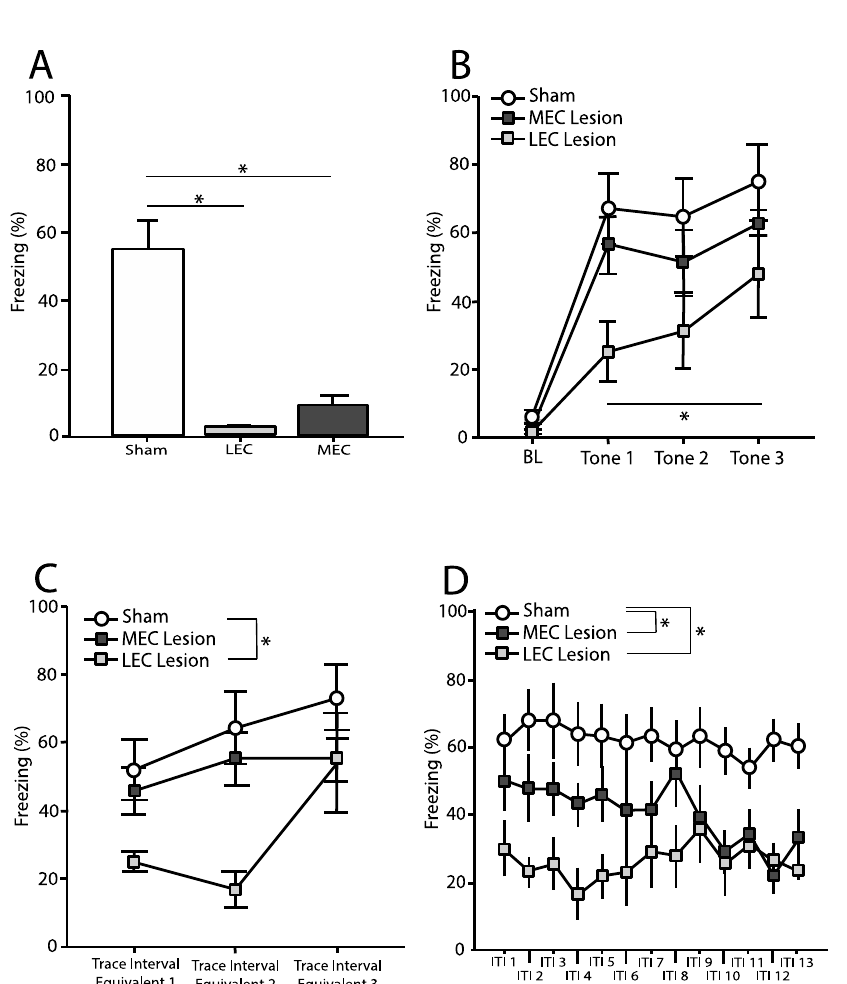
Figure 4. Mean (±SEM) percentage time spent freezing during the context test and tone test for rats trained using delay conditioning . ( A ) Freezing during the entire 8-min context test. Both lesion groups show a deficit in freezing to context. ( B ) Baseline (BL) freezing taking place during the first 180 s of the tone test, prior to presentation of the first tone as well as freezing during each 16-s tone presentation. * Indicates that LEC lesioned rats froze significantly less during the tone compared to control rats. ( C ) Freezing during the 28-s trace interval equivalent following each tone presentation.